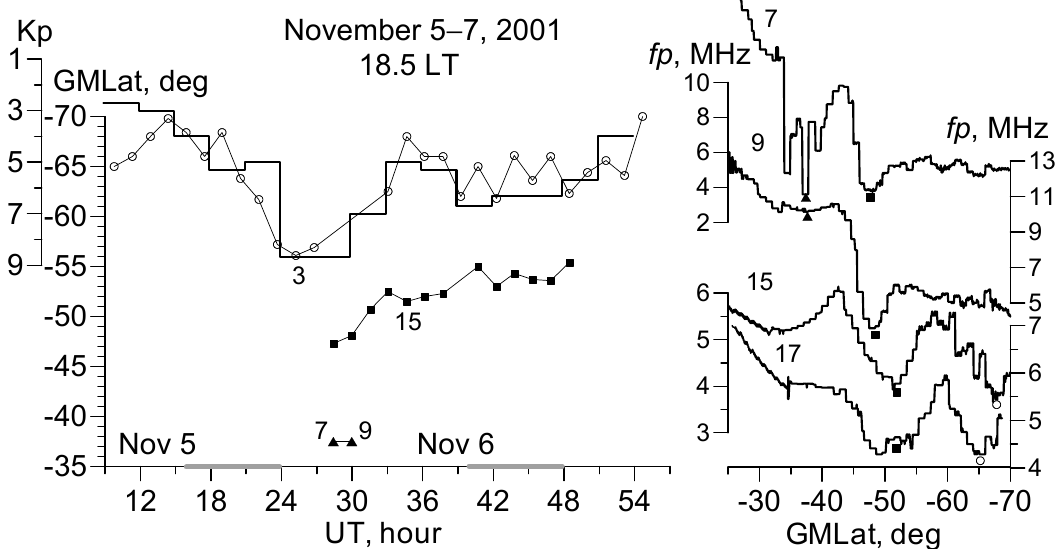
Figure 4. The variations in the trough positions during 5–7 November 2001, in the Southern hemisphere at 18.5 LT. The designations are the same as in Figure 1. The time is counted from 09 UT on 5 November.